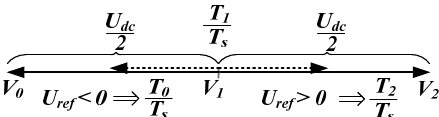
Fig. 2. Vector plane for 1-DM modulation of single-phase DC/AC converter.